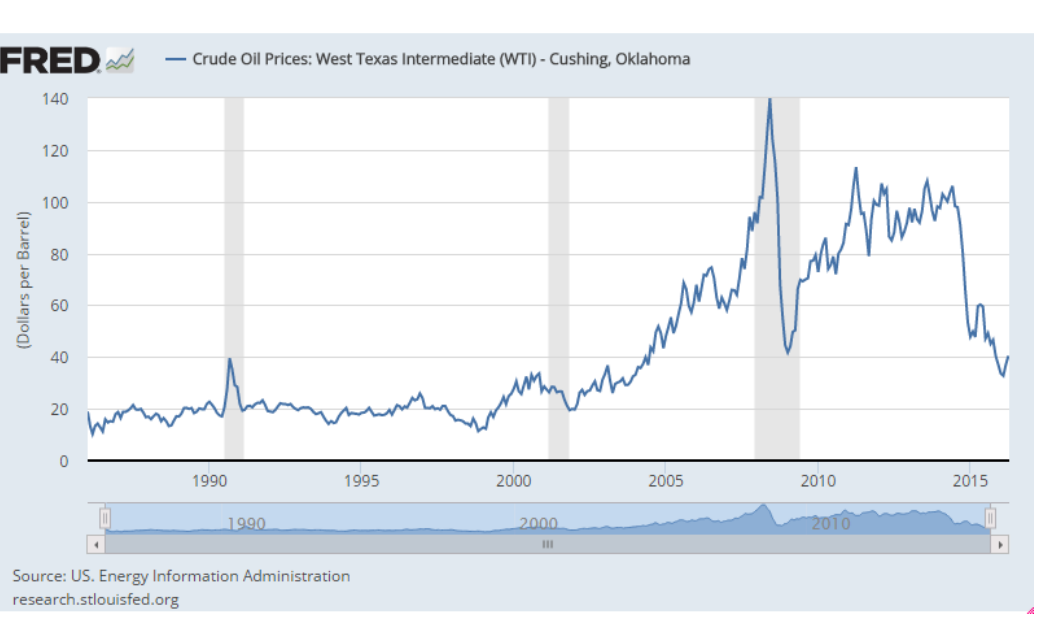
Figure 1. Crude oil prices: West Texas Intermediate (WTI) (1986–2016), Federal Reserve Economic Data.